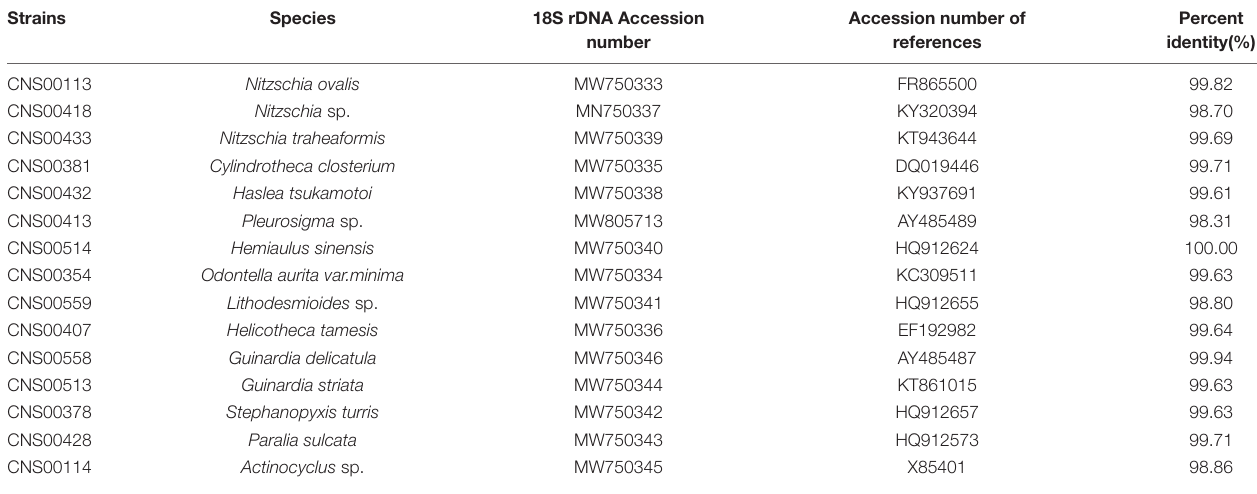
TABLE 1 | 18S rDNA information of 15 strains from the Phylum Bacillariophyta.